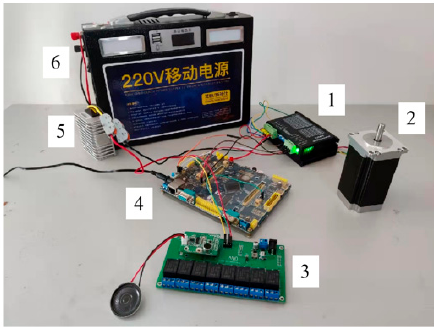
Figure 13. Voice test system for walking. 1 represents the motor driver, 2 represents the electric motor, 3 represents the voice control module, 4 represents the microcontroller, 5 represents the transformer, and 6 represents the ba tt ery.